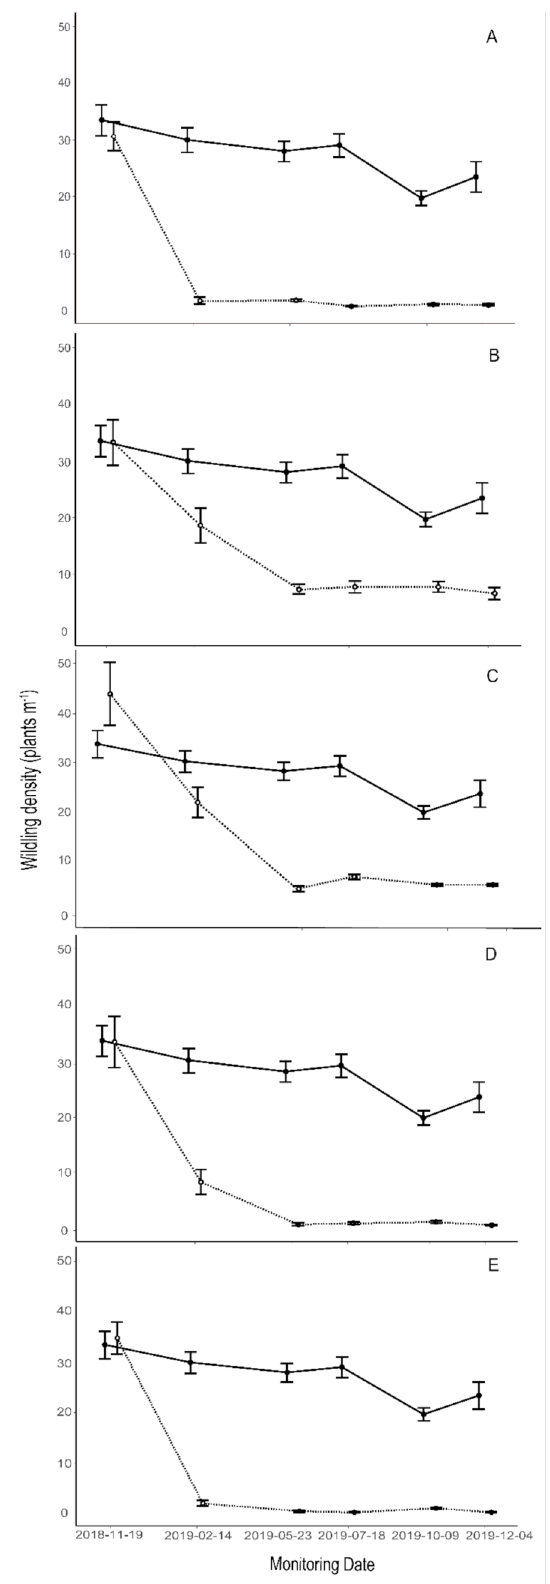
Figure 3. Graphs showing the effect of each treatment (dashed lines) on wildling density (mean ± SE), compared with the Control plots (solid line): ( A ) Cutting; ( B ) Herbicide 0.5%; ( C ) Herbicide 1.0%; ( D ) Herbicide 1.5%; ( E ) Herbicide